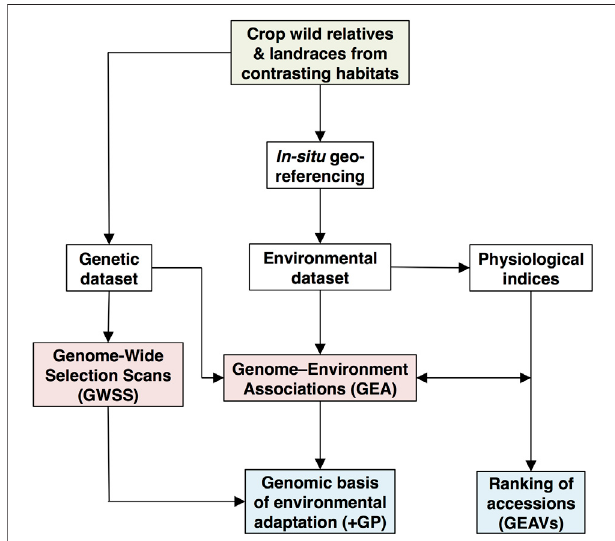
FIGURE 1 | Analytical pipeline to infer genome-wide signatures of environmentaladaptationincropwildrelatives(CWR)andlandracesthatspan heterogeneous environments. The green shaded box refers to gene bank collections, while white, red and blue shaded boxes represent input data, analytical models and output inferences, respectively (Cortés et al., 2020a; Cortés et al., 2020b; Cortés and López-Hernández, 2021). Genomic prediction (GP) and genomic-estimated adaptation values (GEAVs) promise speeding up plant breeding